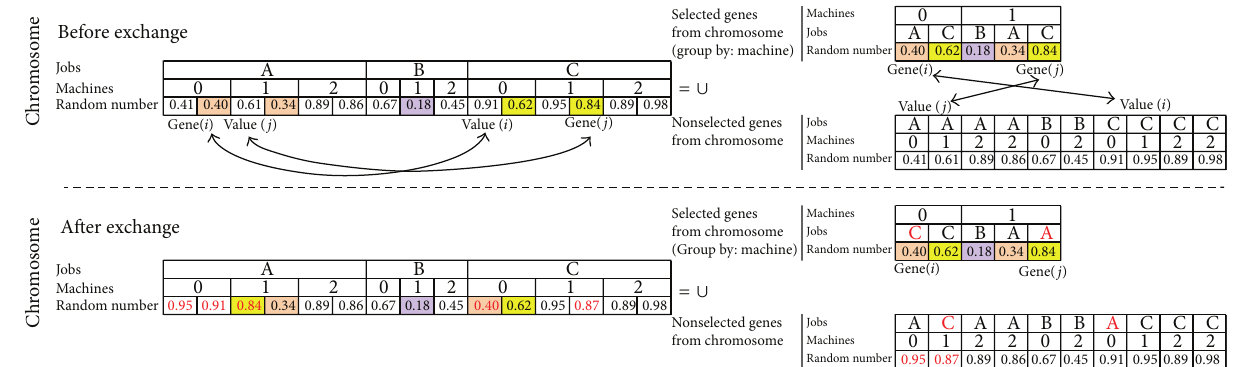
Figure 9: An example for calibration of random numbers on the chromosome for intramachine exchanges.